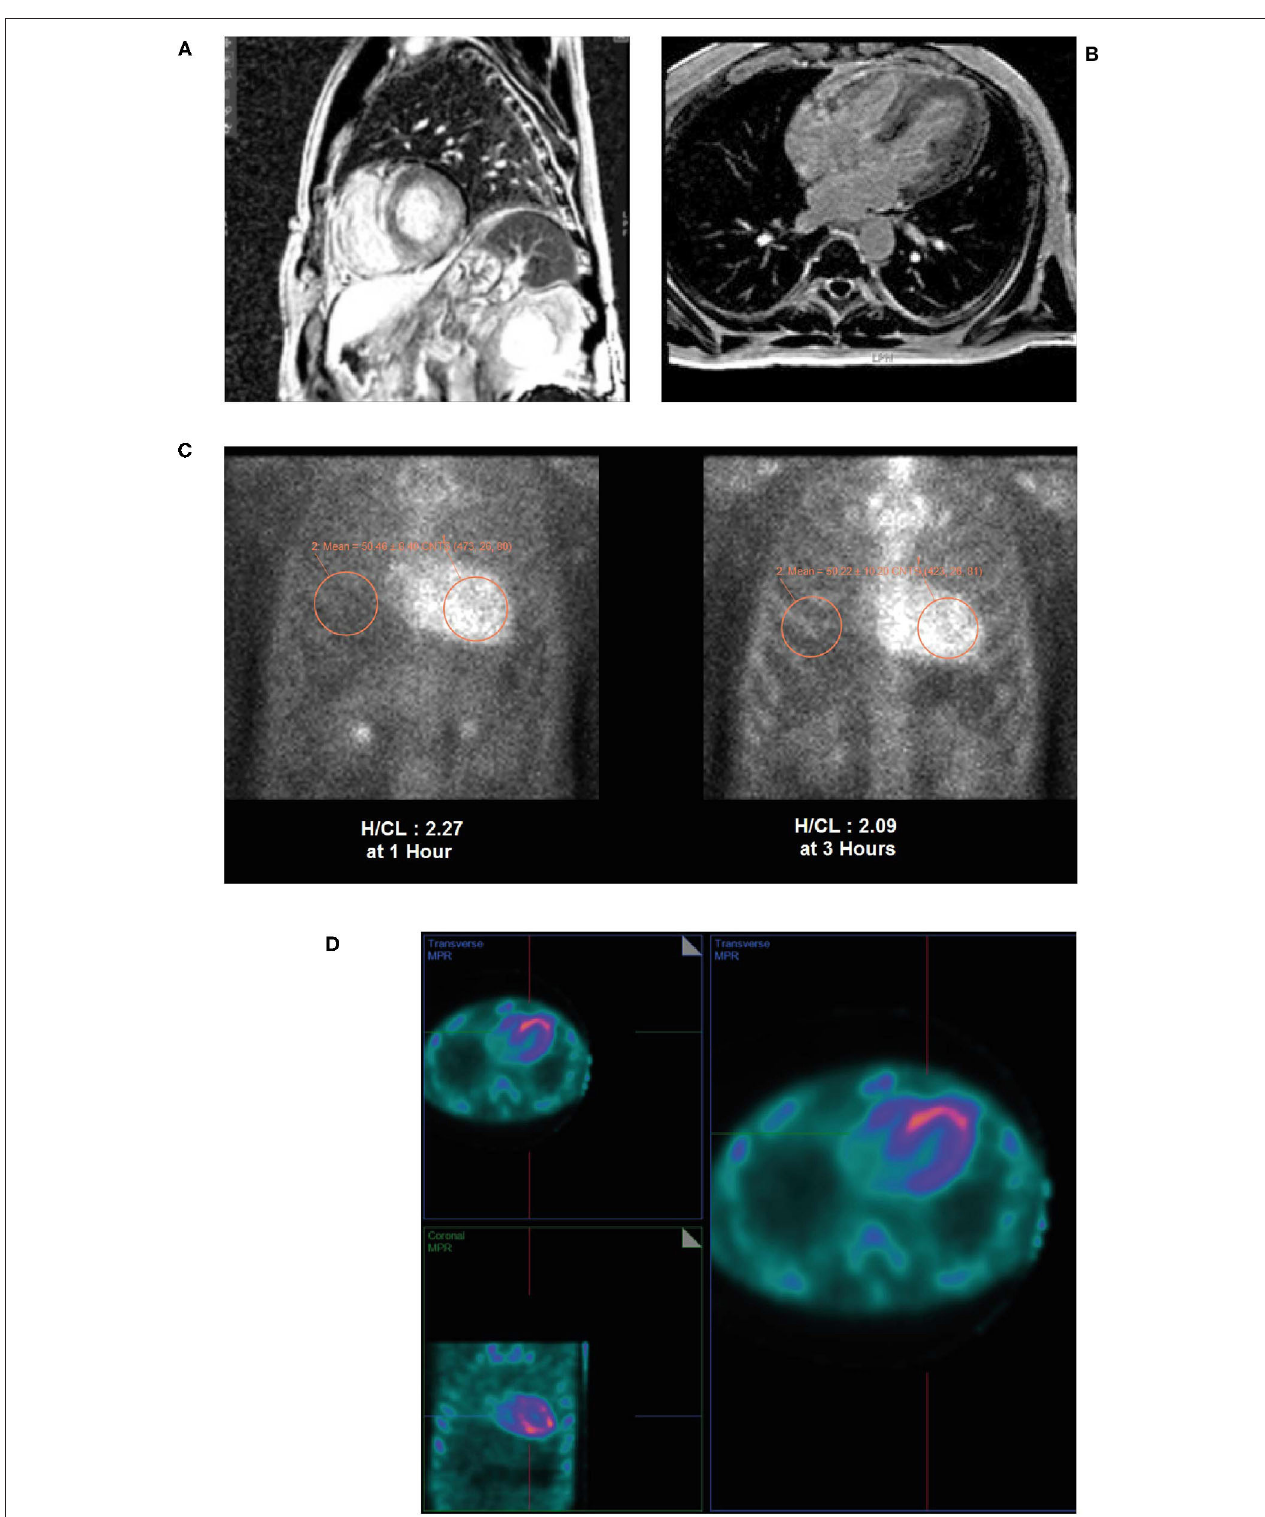
FIGURE 11 | Cardiac MRI (A,B) showing patchy contrast enhancement pattern of the myocardium involving the left ventricular lateral wall base, and mid myocardium of the base to mid ventricle of the LV septum, and mid myocardium of the RV free wall from base to mid ventricle associated with hypertrophy. A planar PYP scan (C) revealed intense cardiac uptake at 1h and 3h (H/CL ratio 2.27 and 2.09, respectively), with SPECT scan (D) at 1h demonstrating tracer uptake in myocardium and no residual LV blood pool activity. H/CL, heart to contralateral lung ratio; LV, left ventricular; MRI, magnetic resonance imaging; PYP, pyrophosphate; RV, right ventricular; SPECT, single-photon emission computed